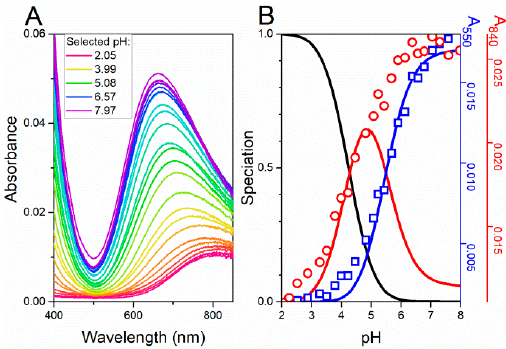
significant digits, provided by HYPERQUAD [35] are given in parentheses.